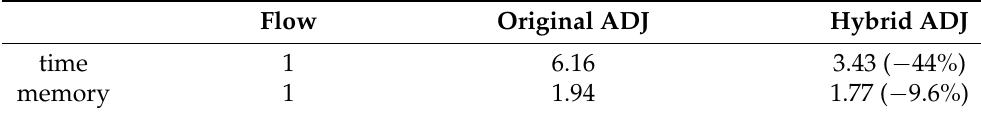
Table 4. Comparison of time and memory consumption among different solvers for the Aachen